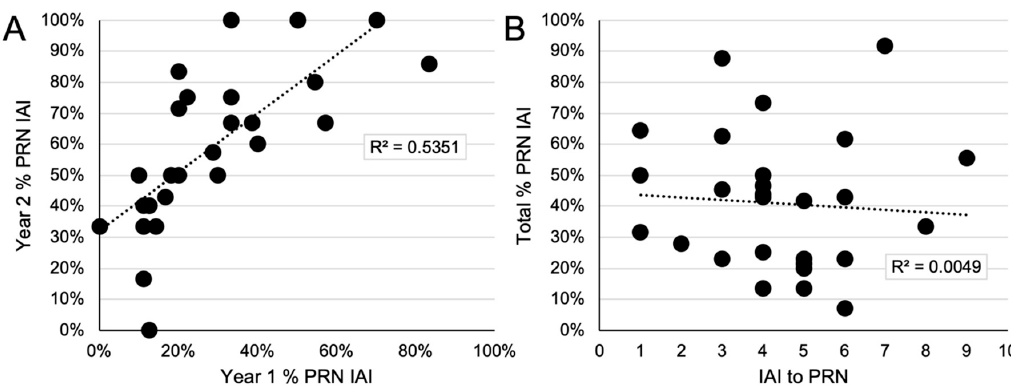
Figure 2 . Linear correlations between intravitreal aflibercept injection (IAI) administrations. ( A ) The percent of pro re nata (PRN) visits resulting in IAI during year 1 versus the percent of PRN visits resulting in IAI during year 2. A significantly positive linear correlation was observed (R = 0.73, p < 0.0001; black dotted line). ( B ) The percent of IAI required to achieve a ≥ 2-step DRSS improvement versus the total percent of PRN visits requiring IAI through year 2. No significant correlation was observed (R = − 0.07, p = 0.73; black dotted